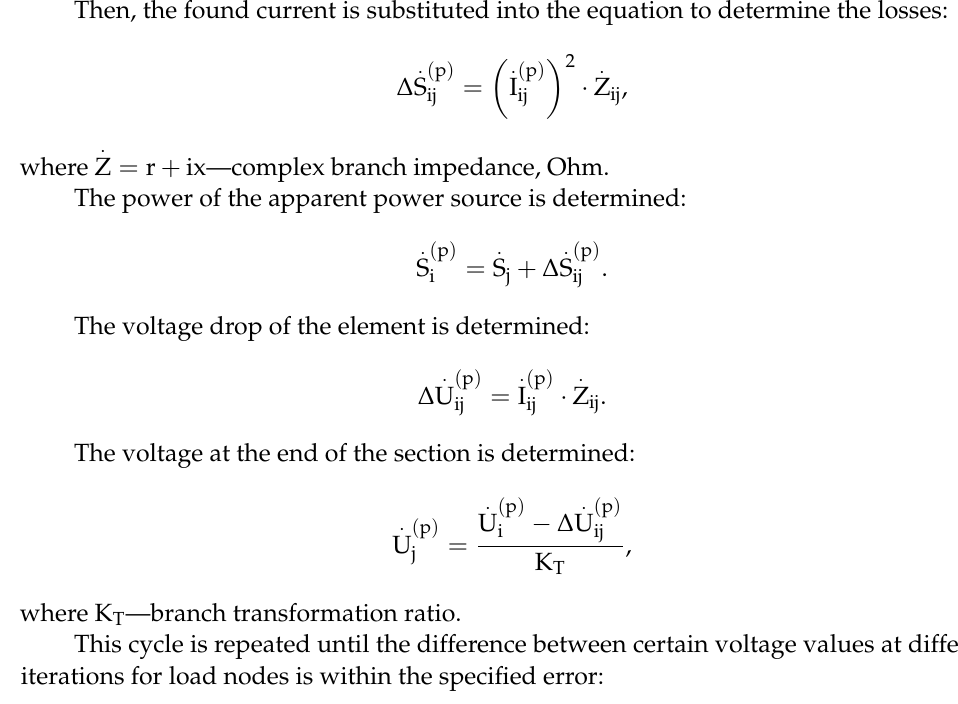
Figure 3 indicates: η CS —control station efficiency; f—the voltage frequency at